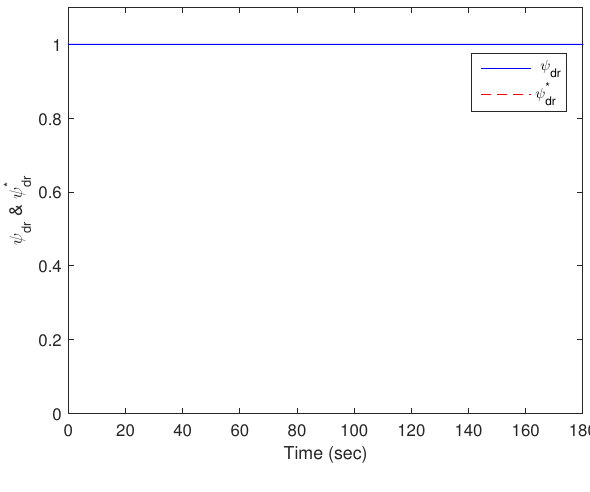
Figure 8. The fluxes ψ dr and ψ ∗